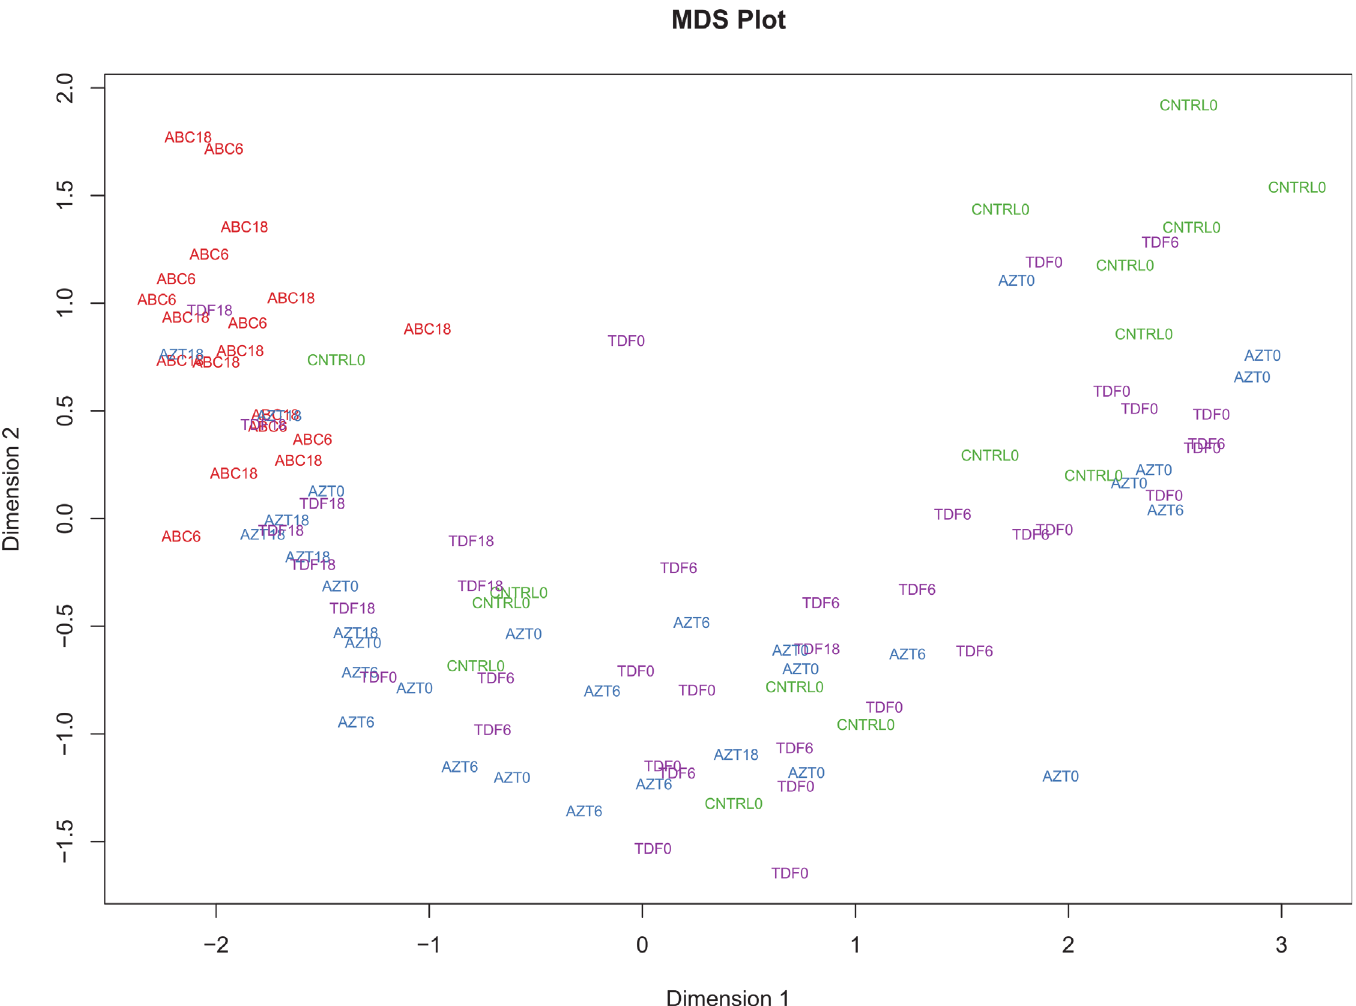
Figure 2. The multi-dimensional scaling plot (MDS) shows that by and large ABC 6 and ABC 18 – 24 samples are separated from other samples in the study. Distances in the plot represent root-mean-square deviation (Euclidean distance) for the top 500 genes that best distinguish those samples.